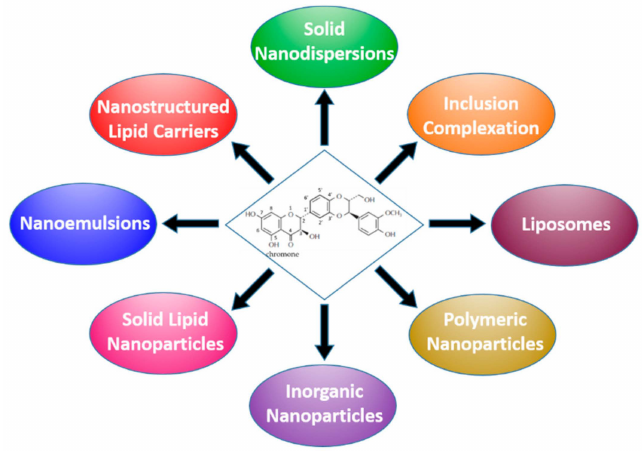
Figure 2. Relevant formulation strategies currently available to improve the bioavailability of